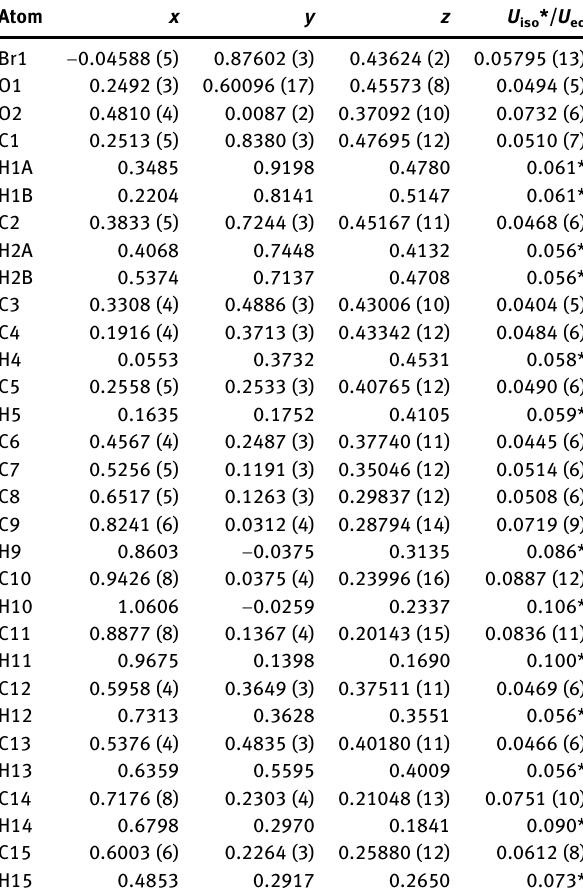
Table  : Fractional atomic coordinates and isotropic or equivalent isotropic displacement parameters (Å 